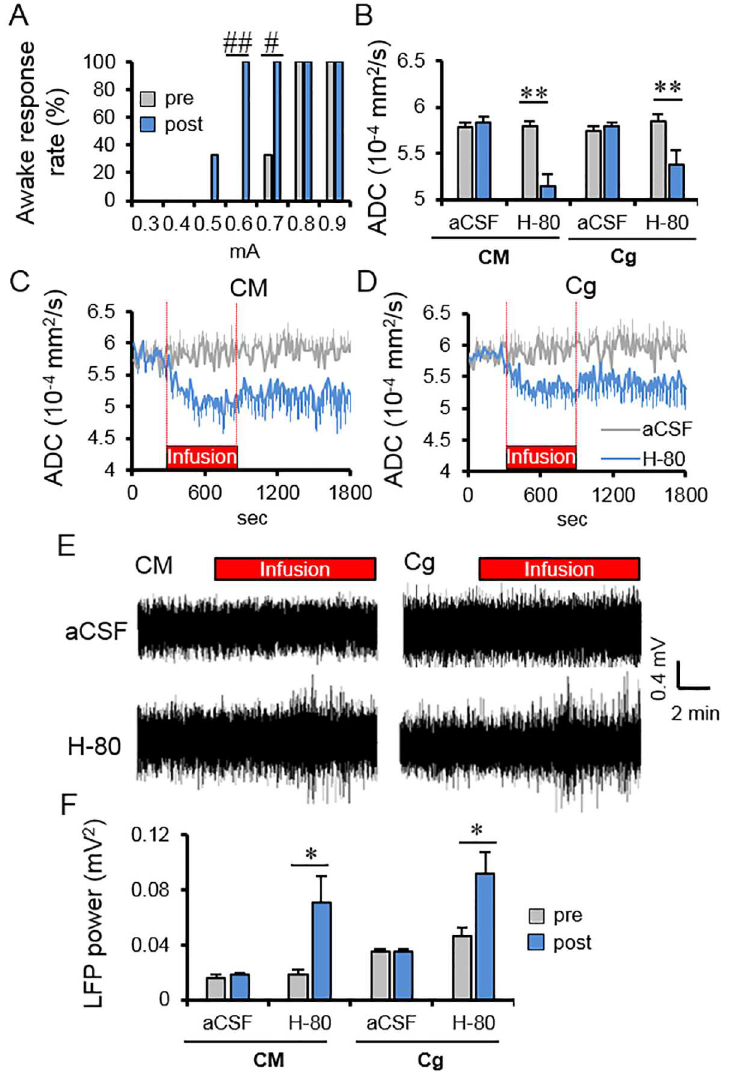
Fig 6. Effects of H-80 infusion in the Central Medial thalamus nucleus (CM) on the Apparent Diffusion Coefficient (ADC), Local Field Potentials (LFPs) and awake response threshold. (A) Percentageof animalsexhibiting an awake response duringCM electricalstimulationafter the CM infusionwith − 80 milliosmole(mOsm) hypotonicartificial cerebrospinal fluid (aCSF) (H-80; n = 6). (B) Average ADC changein the CM and cingulatecortex (Cg) before and after H-80 or aCSF infusion in the CM ( n = 6 for each condition). Average time course of ADC change at the CM (C) and Cg (D) with the infusion of aCSF and H-80. (E) Representative local field potentials (LFP) signals at CM and Cg duringCM infusionwith aCSF (upper)or H- 80 (low). (F) Total LFP power (frequency range: 1–70 Hz) in CM and Cg before and after CM infusionwith H- 80 ( n = 6) or aCSF ( n = 6). Time course and bar plots exhibitmean ± the standarderror of the mean (SEM). ** p < 0.01 (Paired t -test betweenpre and post), # p < 0.05, ## p < 0.01 (Fisher’s exact test). Data for minimumamplitudesof individualrats can be found in S5 Data. ADC data of individual rats found in S3 Data. LFP power data can be found in S4 Data.